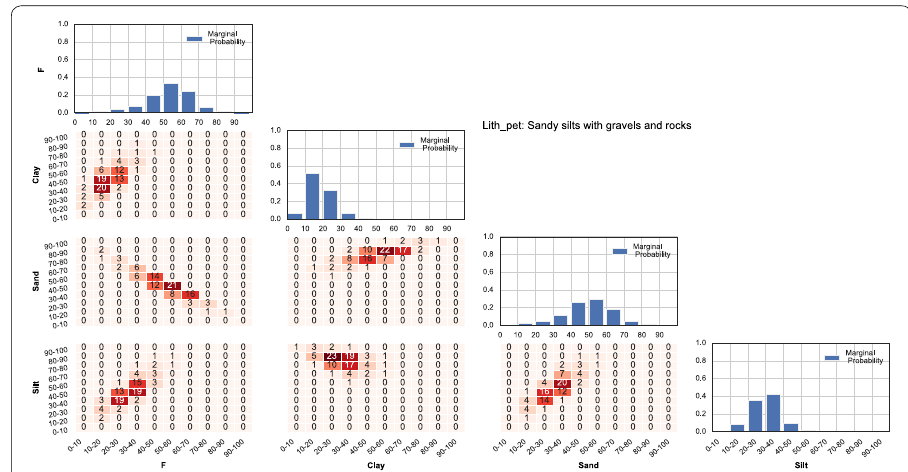
Fig. 1 Example of marginal and 2‑joint PDFs for the percentages of sand, silt, clay, and F . Numbers given within each mesh are percentages. The distributions are here given for the rock type: “Silty sands with gravels and